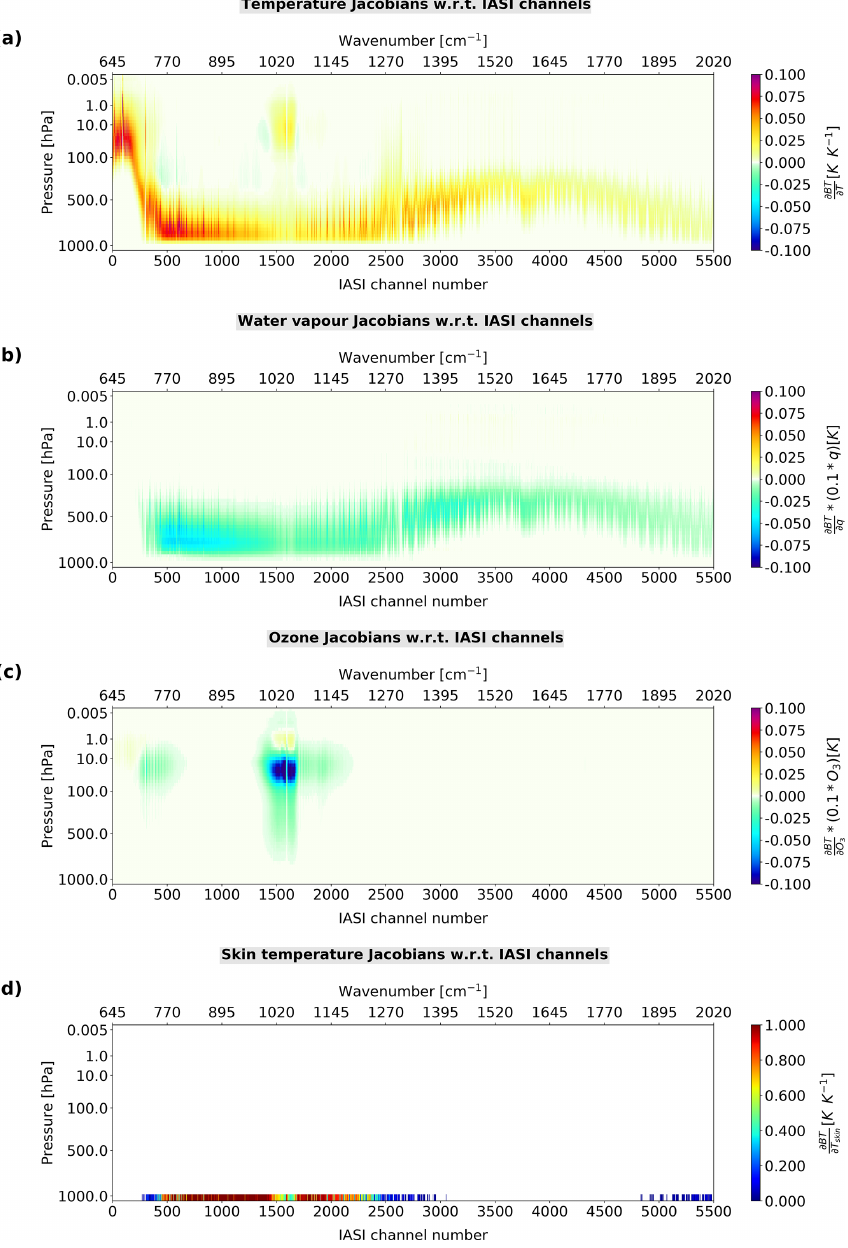
Figure 3. Mean of temperature (a) , water vapour (b) , ozone (c) and skin temperature (d) Jacobians of the first 5499 IASI channels (bands 1 and 2) with respect to pressure over the subset of 60 atmospheric profiles (calculated with RTTOV